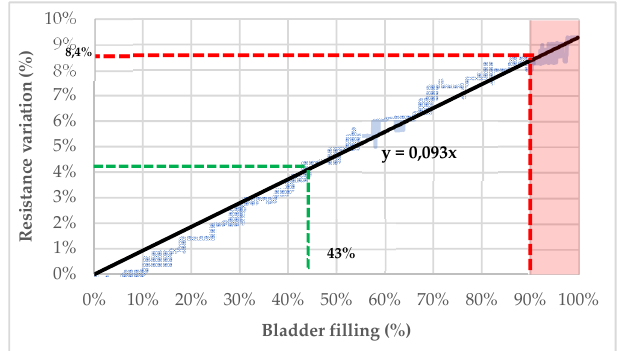
Figure 9. Bladder’s filling estimation based on resistance variation recorded by the Figure 9. Bladder's filling estimation based on resistance variation recorded by the electrodes.